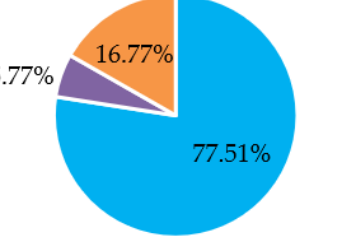
Figure 4. Ownership of agricultural land in the year 2018. Source: own representation based on the Annual Report of the Slovak Land Fund, 2019 [49].